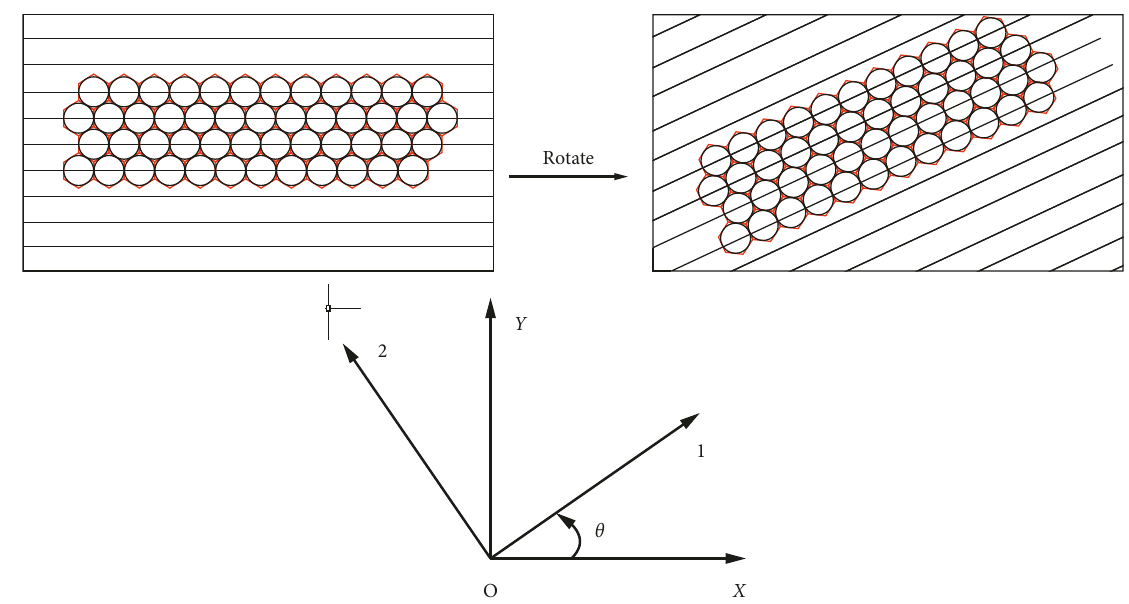
Figure 4: Fiber direction represented by lattice rotation.